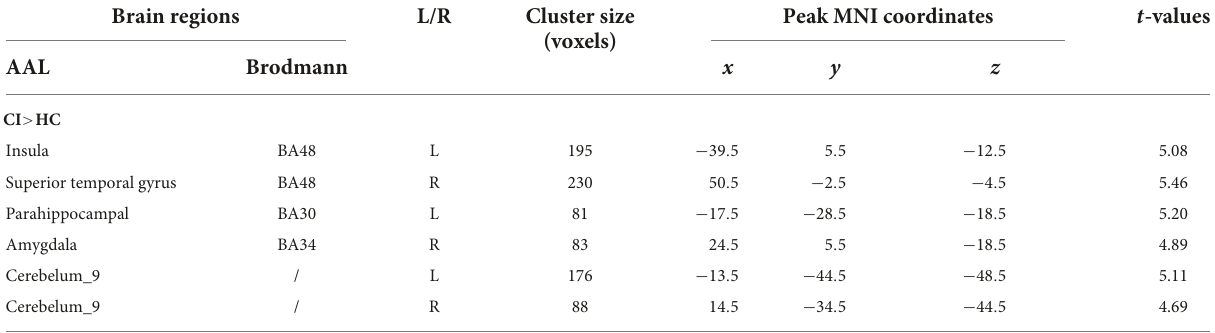
TABLE 2 Regions with changed dfALFF between patients with CI and